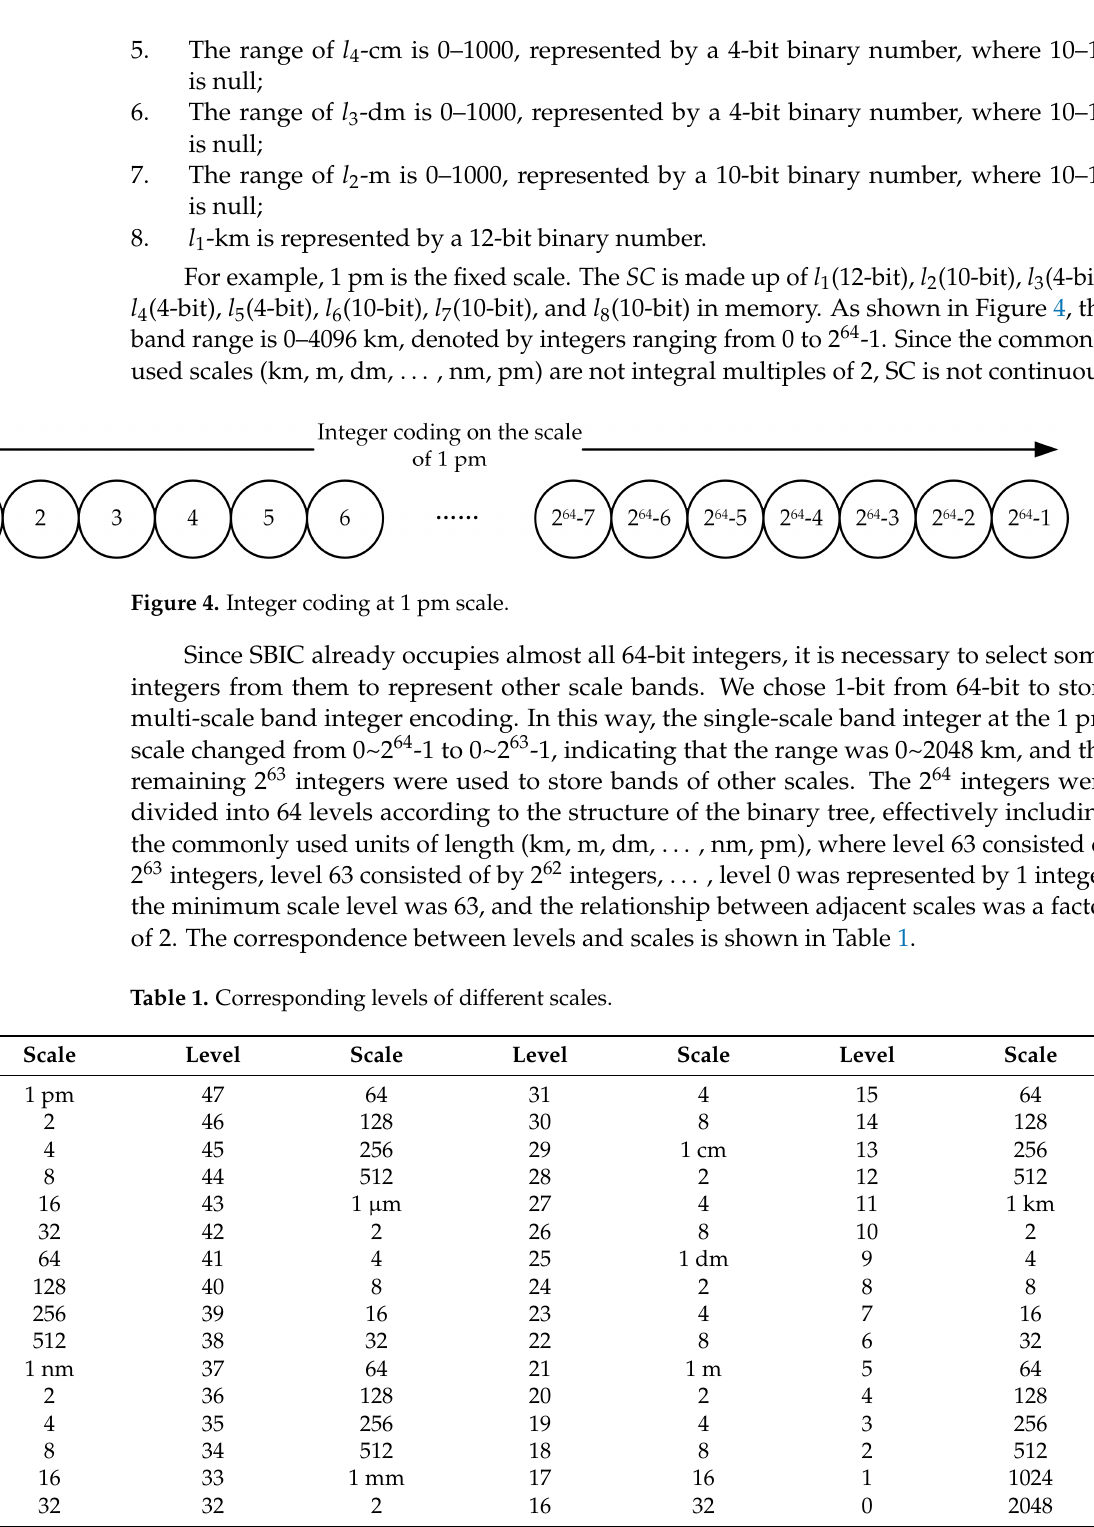
As shown in Table 1, 64 scales are represented by 64-bit integers, namely: 1